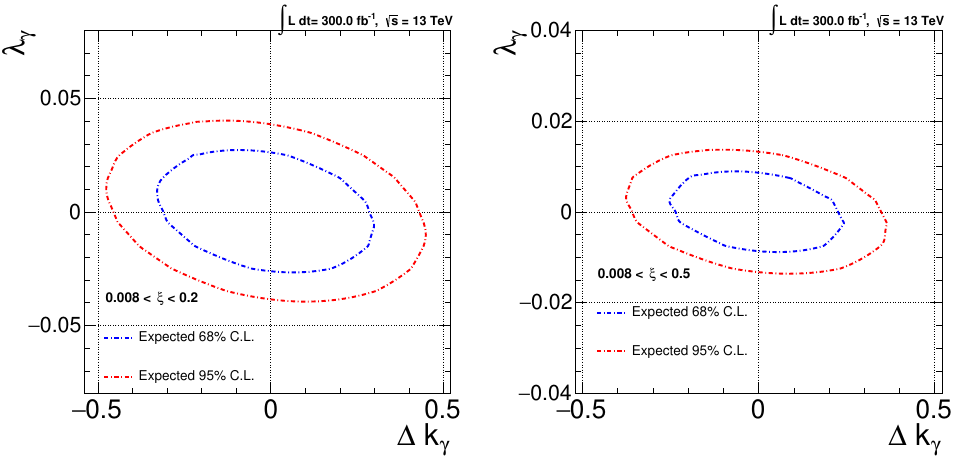
Figure 10 . Two-dimensional 68% and 95% C.L. expected limit on the (cid:21) (cid:13) and (cid:1) k (cid:13) couplings assuming 0.008 < (cid:24) < 0.2 (left) and 0.008 < (cid:24) < 0.5 (right) and considering the IL corresponds to 300 fb (cid:0) 1 .